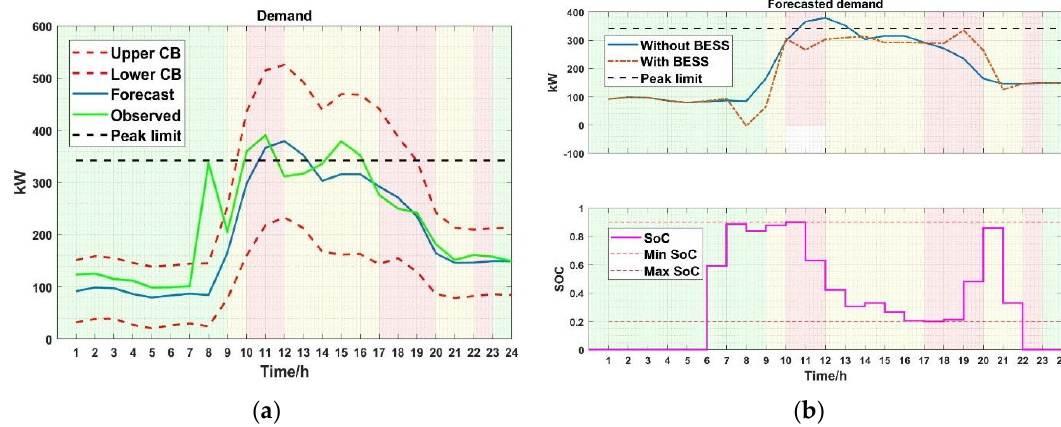
Figure 9. ( a ) Day ahead probabilistic demand forecast vs. observed demand ( b ) PEVs’ SoC schedule vs. the expectation of the forecasted demand before and after DO with probabilistic demand forecast via confidence